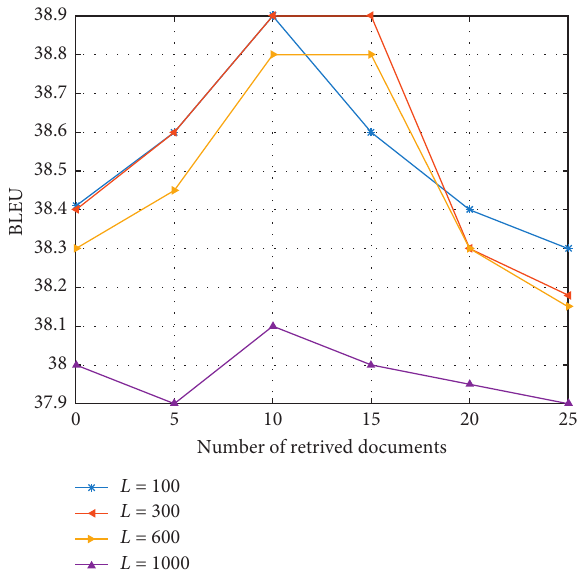
Figure 7: The impact of topic-related features on machine translation